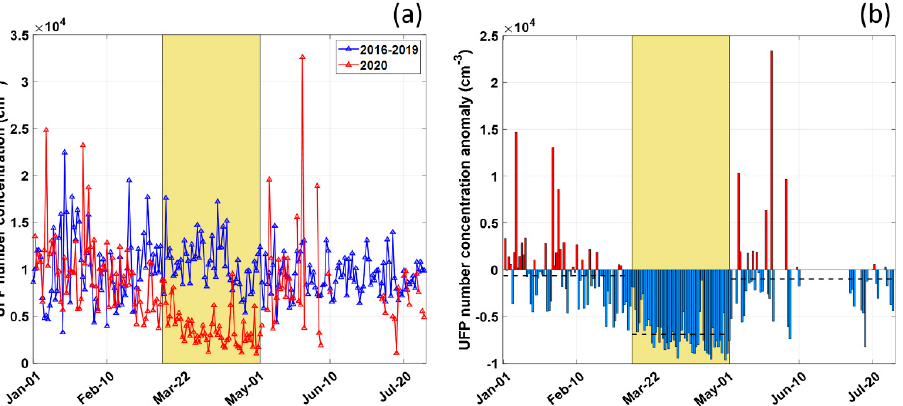
Figure 3. ( a ) Time series of daily ultrafine particle (UFP) concentration for the measurement period from January to July 2020 and the corresponding period in the years 2016–2019. ( b ) Anomalies for each day were calculated from the difference with a baseline value (mean concentration level for each phase of the period 2016–2019). The lockdown period is evidenced by a yellow band.